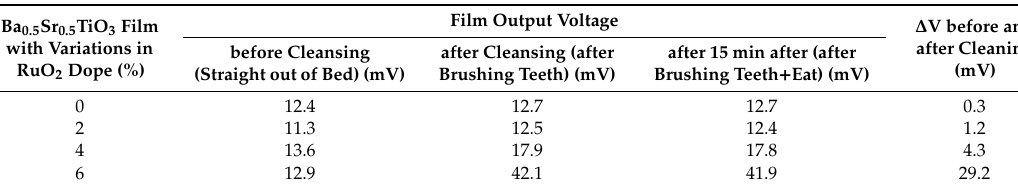
Table 2. Voltage di ff erence measurement data of Ba 0.5 Sr 0.5 TiO 3 film doped with RuO 2 in various oral conditions.